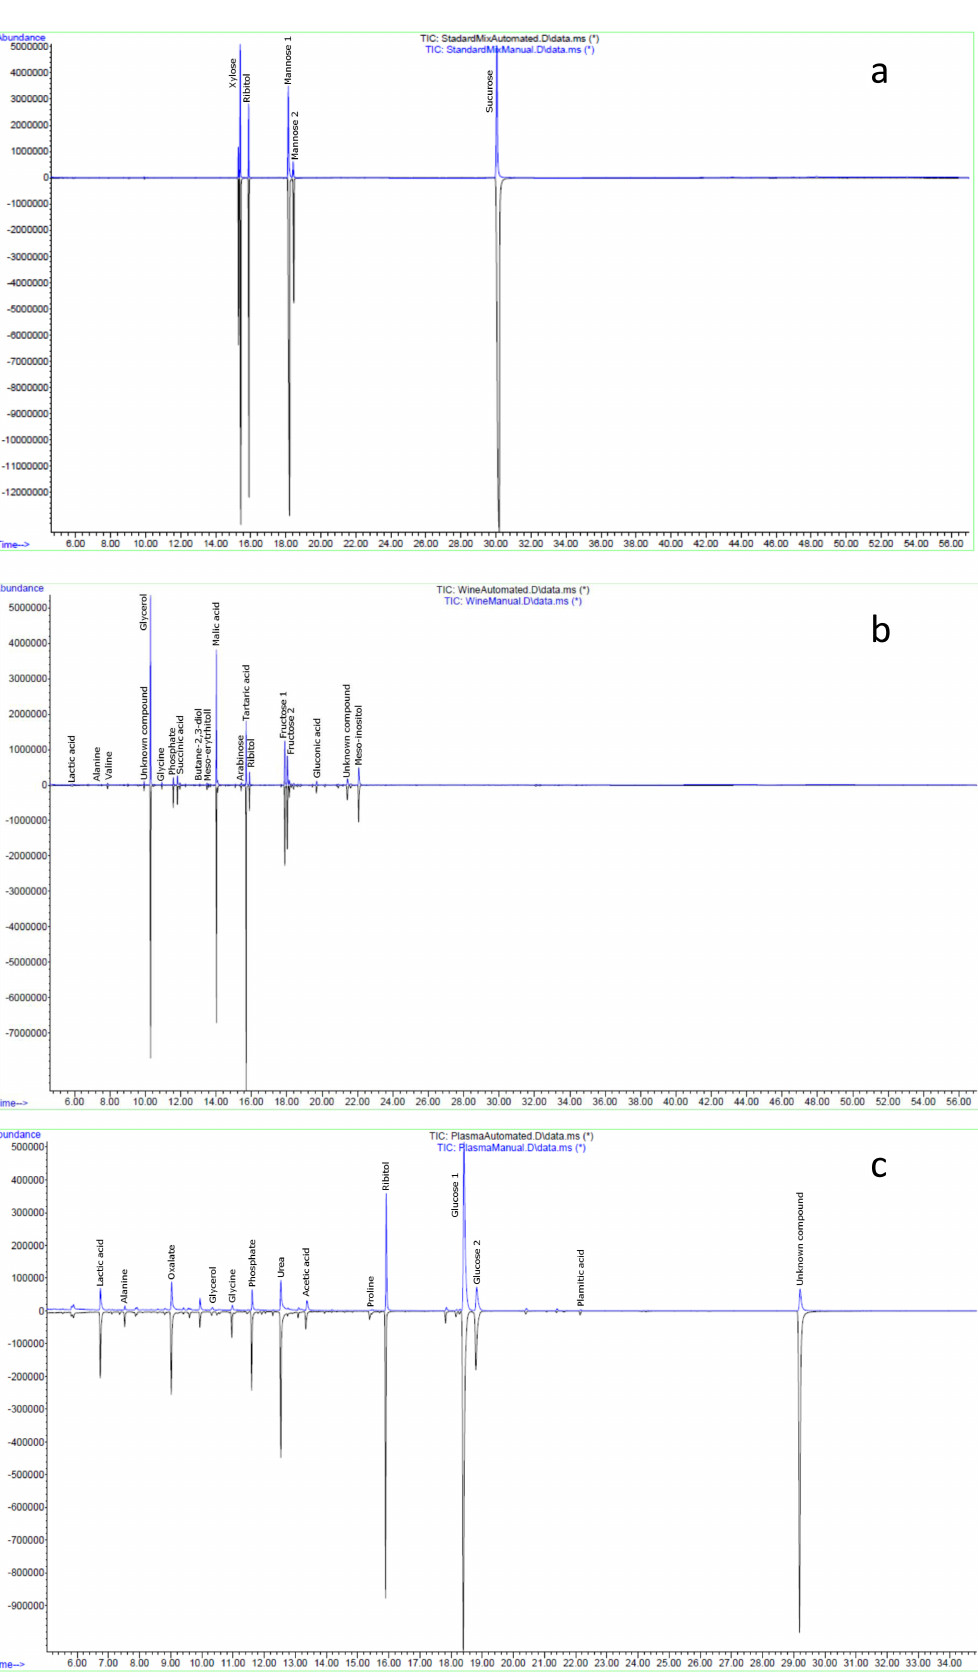
Figure 1. Chromatograms showing the difference between automated and manual TMS derivatisation protocols for standard mix ( a ); wine ( b ); and plasma ( c )